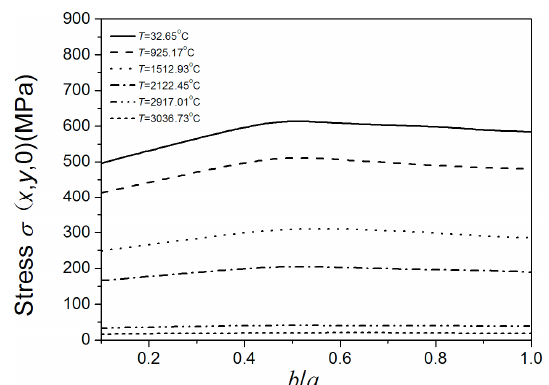
Figure 9. b / a ratio dependence of the highest σ ( , ,0) x y on the same crack edge under different